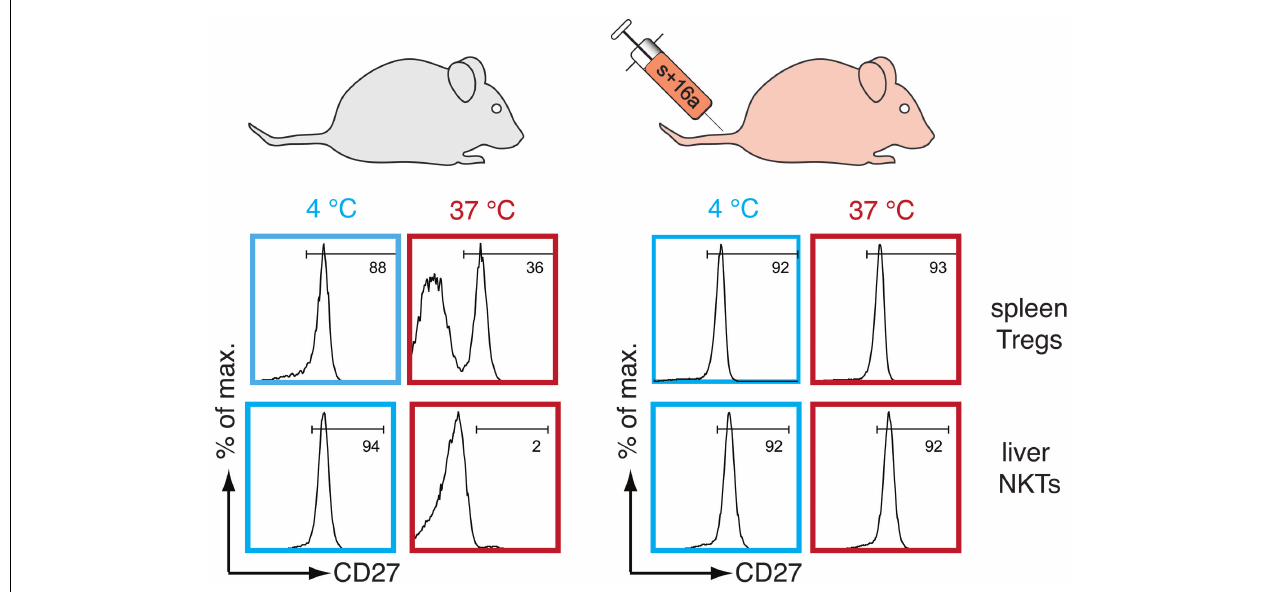
panel). These cells also rapidly shed CD62L and expose phosphatidylserine at their cell surface (not illustrated here). Intravenous injection of an anti-ARTC2.2 blocking nanobody (s + 16a) before harvesting of the organs prevents ADP-ribosylation of P2X7 during cell manipulation and P2X7-dependent CD27 shedding when cells are re-incubated at 37°C (right